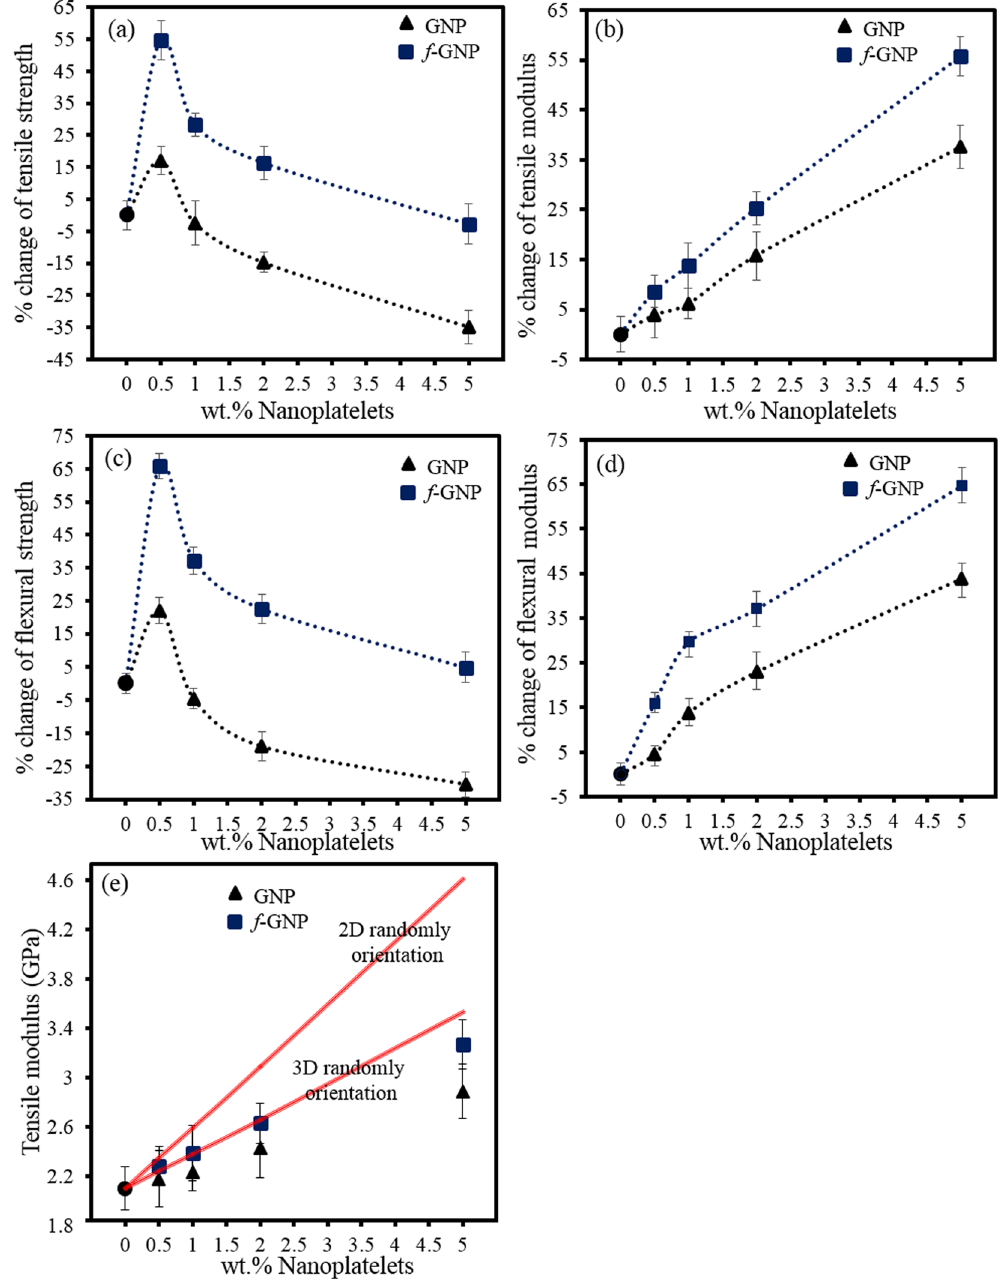
Figure 5. Changes percentage in various mechanical properties of nanocomposites compared to pure epoxy as a functional of nanoplatelets loadings ( a – d ), and comparison of the Halpin-Tsai model with experimental tensile modulus results ( e